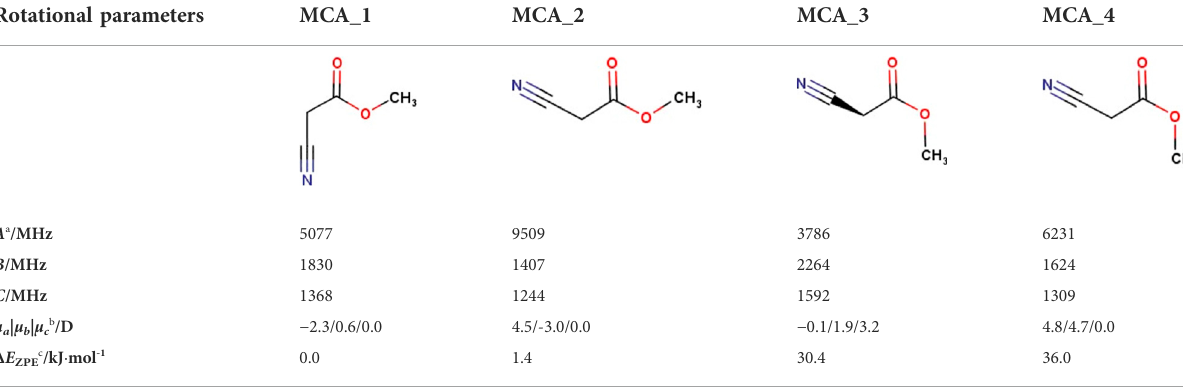
TABLE 1 Calculated parameters for the conformers of MCA at the B3LYP-D3/aug-cc-pVTZ level of theory. Rotational